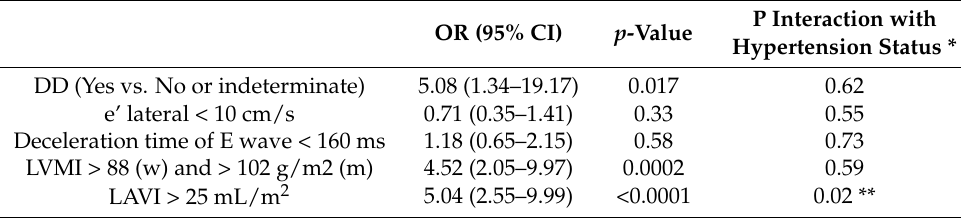
Table 1. Association of diastolic dysfunction, diastolic functional parameters (e’ or deceleration time) and cardiac remodeling variables (LVMI/LAVI) with paroxysmal atrial fibrillation status in multivariable conditional logistic regression